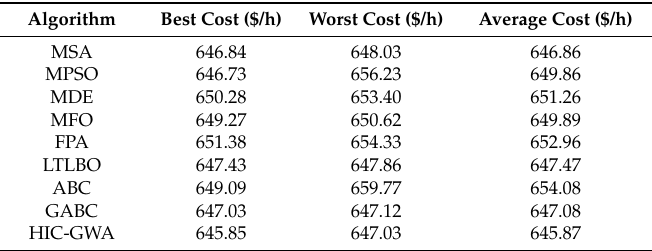
Table 19. Comparisons of the results obtained for case 2.